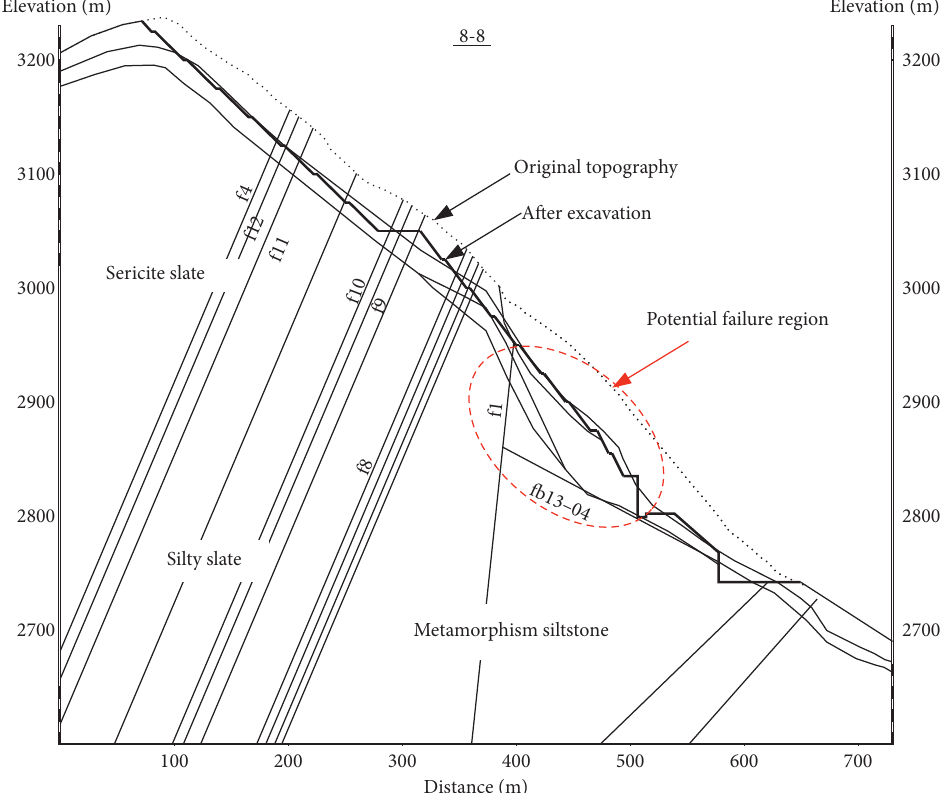
Figure 11: Typical section to show the potential failure